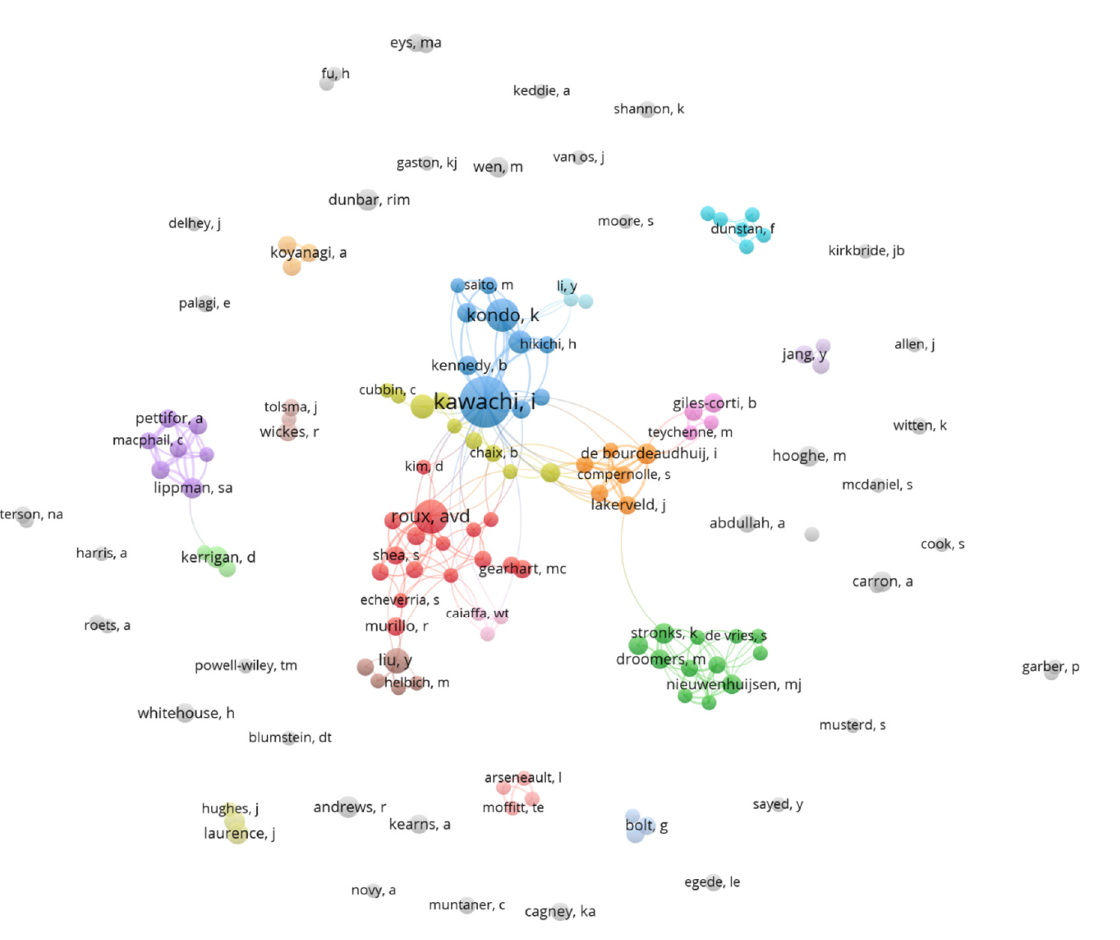
Figure 5. Co-author network for “social cohesion.” The size of each node (circle) indicates the number of documents associated with an author [38]. Lines represent co-occurrence between two authors and appear when authors co ‐ occur at least once.